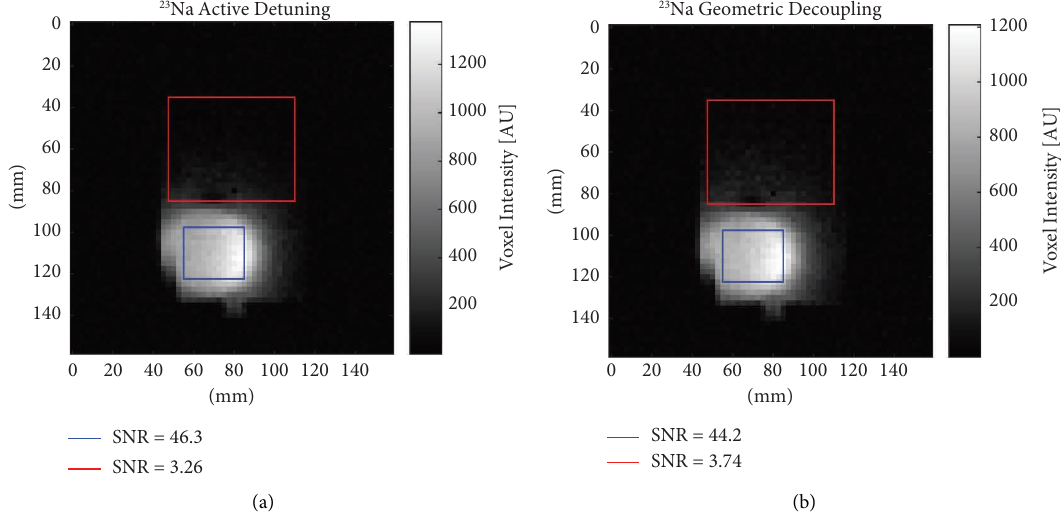
Figure 9: Images using the double-tuned birdcage with receive loop. (a): Sodium image receiving with a single loop using active detuning. (b): Sodium image receiving with a single loop using purely geometric